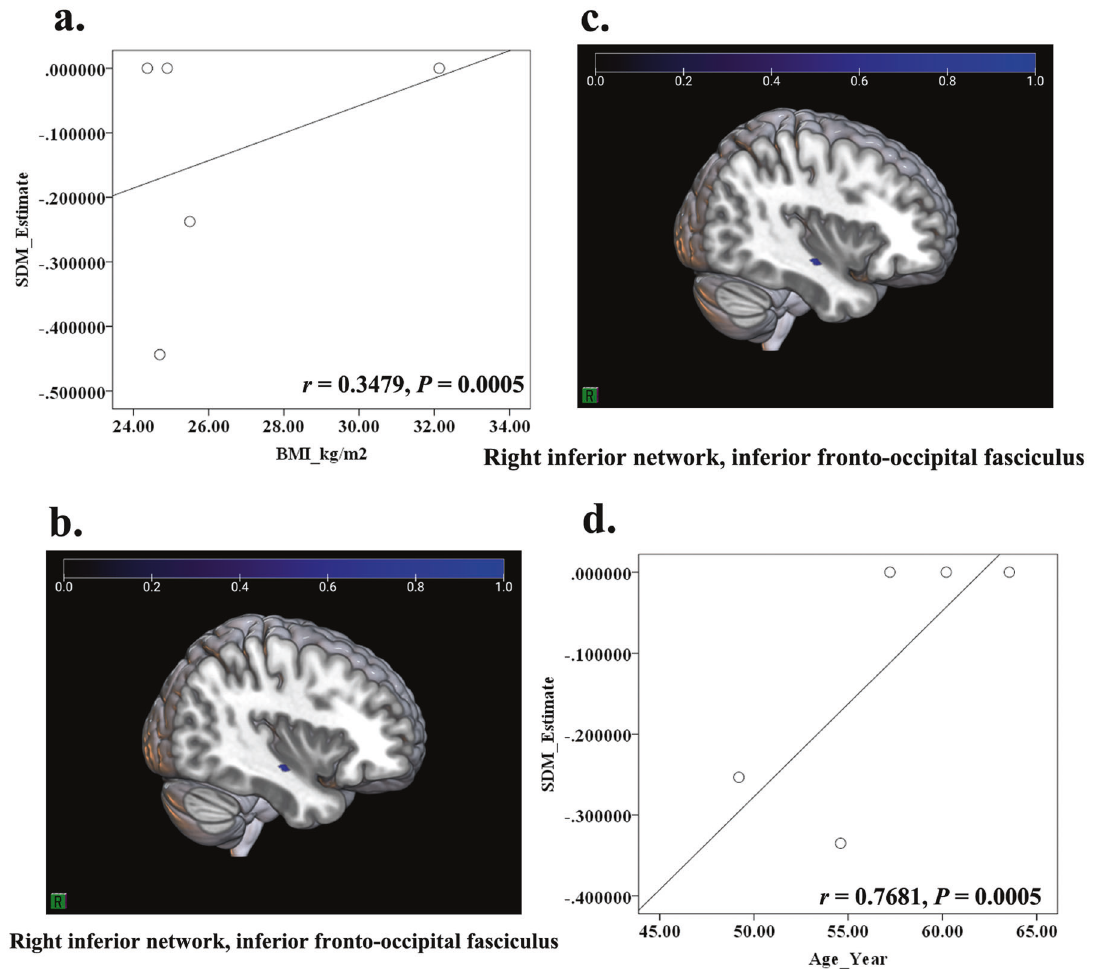
Fig. 5 The relationship between BMI, age and decreased FA in patients with T2DM-CD. According to the meta-regression, both the BMI ( a , c ) ( r = 0.3479, P < 0.0005) and age of patients ( b , d ) ( r = 0.7681, P < 0.0005) were positively related with the decreased FA in